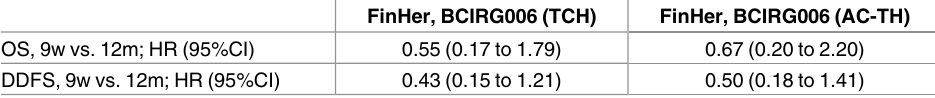
Table 5. Hazard ratios for indirect pairwise comparison of 12 months vs. 9 weeks, via the Bucher method. FinHer, BCIRG006 (TCH) FinHer, BCIRG006 (AC-TH) OS, 9w vs. 12m; HR (95%CI) 0.55 (0.17 to 1.79) 0.67 (0.20 to 2.20) DDFS, 9w vs. 12m; HR (95%CI) 0.43 (0.15 to 1.21) 0.50 (0.18 to